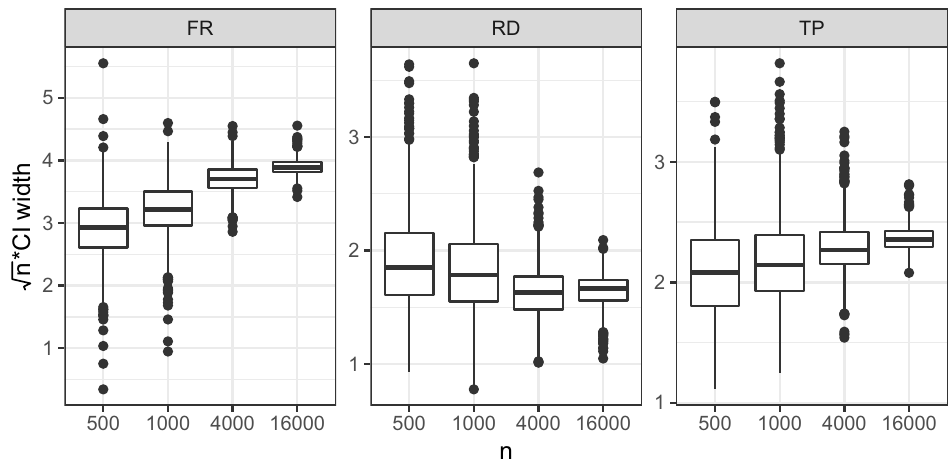
Figure 1: Boxplot of n CI × width for ATE relative to each